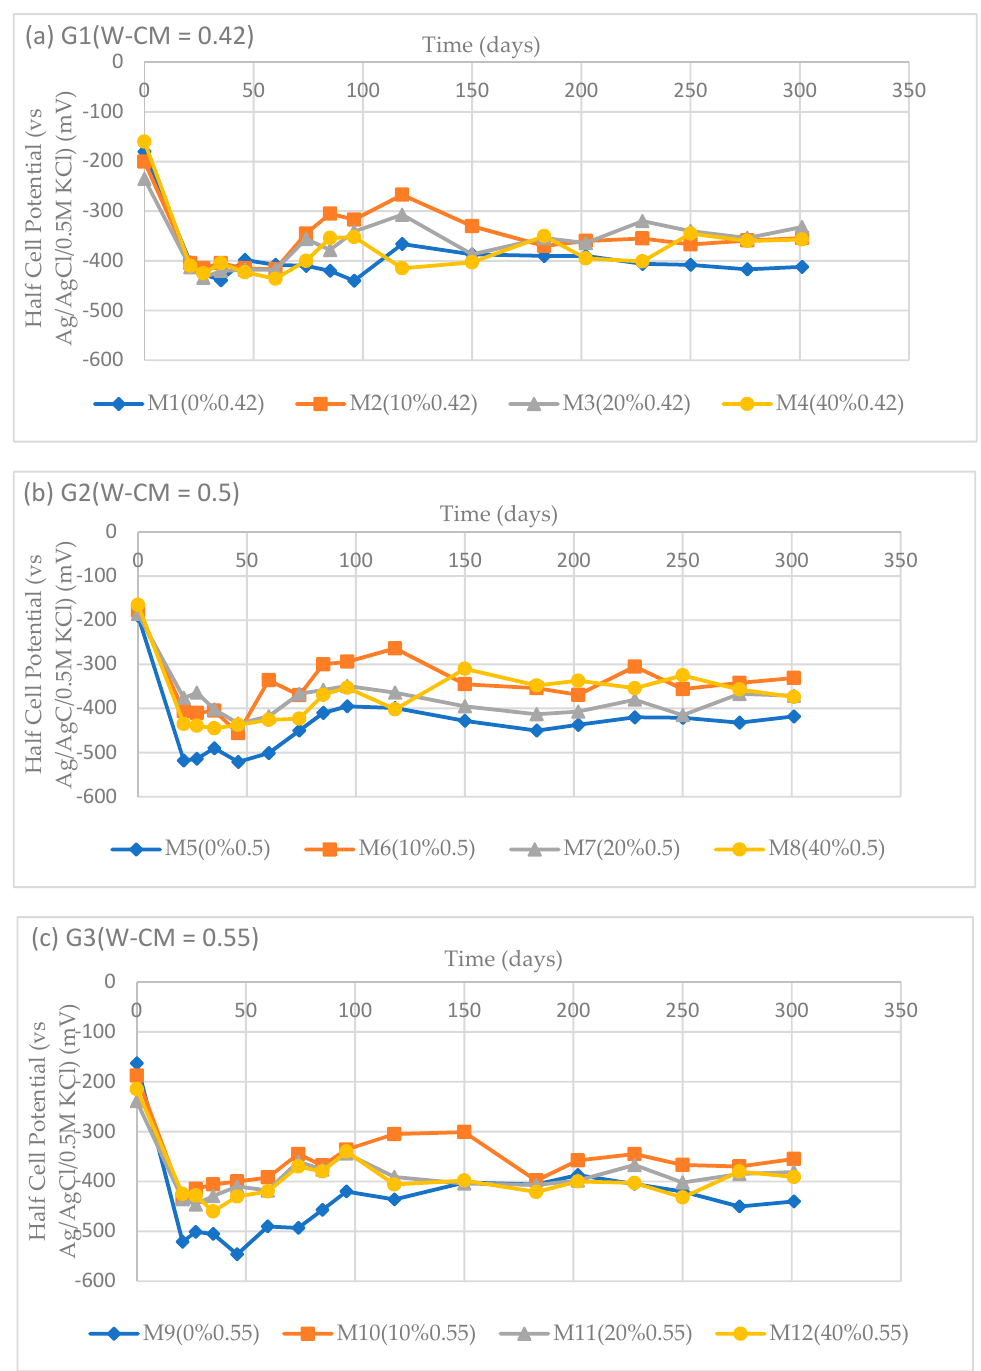
Figure 8. Half-cell potentials of steel bars. ( a ) G1 (W–CM = 0.42); ( b ) G2 (W–CM = 0.50); ( c ) G3 (W–CM = 0.55).